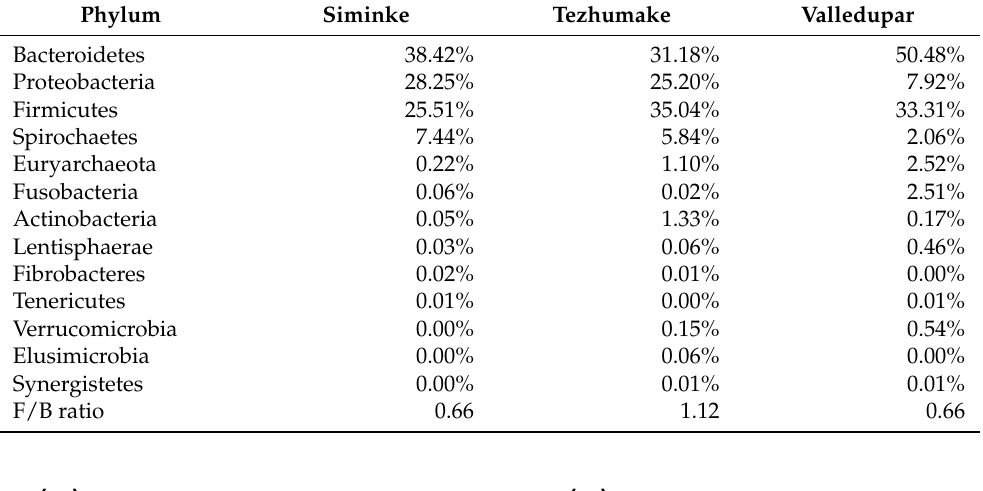
Table A2. Genera distribution in the three locations. Data indicate relative abundances (percentages of OTU counts). Genera with relative abundances lower than 1% were filtered out.